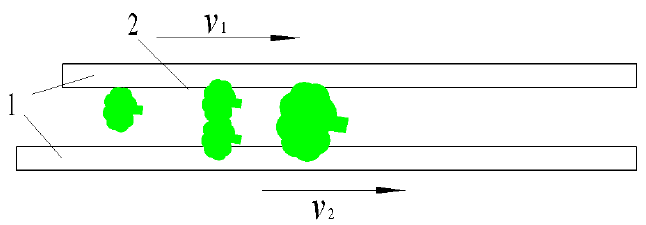
Figure 4. Schematic diagram of blocks above differential round belts, where 1. Belts; 2. Blocks.